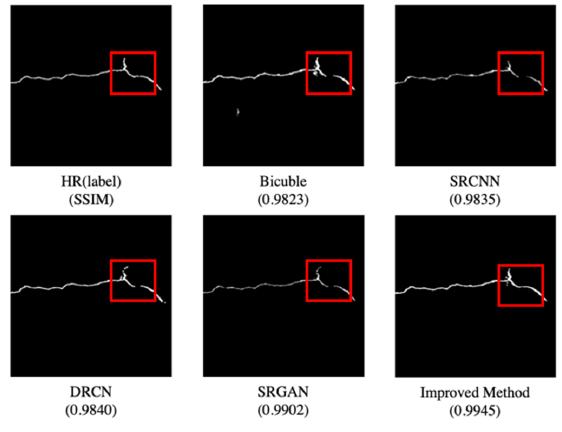
Figure 12. Pavement cracks segmentation comparison.